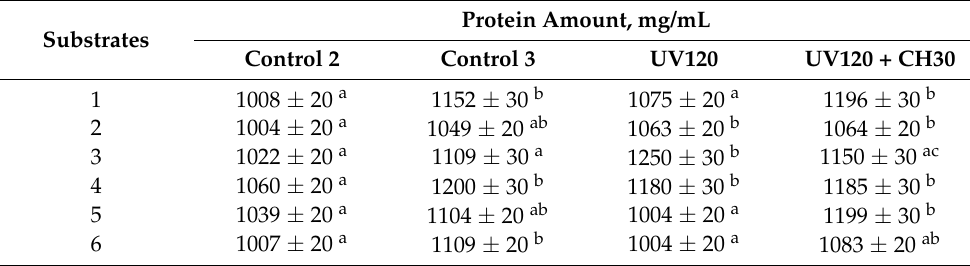
Table 6. The amount of protein produced by A. niger according to the Bradford